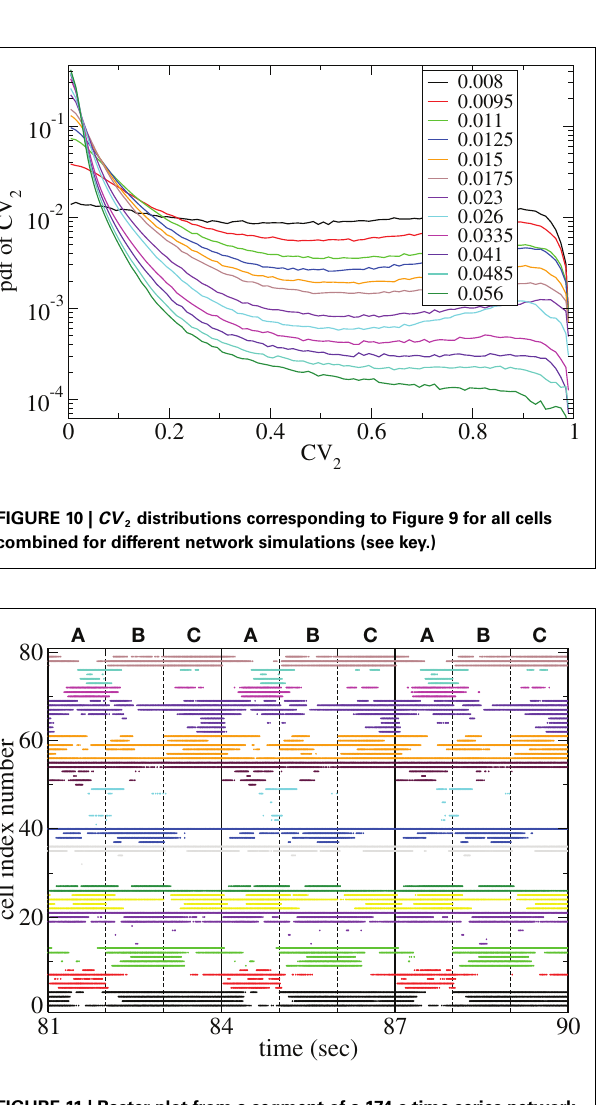
FIGURE 11 | Raster plot from a segment of a 174-s time series network simulation with 100 cells under input switching protocol 1s × 3 stimuli, (see text) cells colored according to assigned cluster. Input strength r C = 0.018 spikes/ms, connectivity ρ = 0.1, tail parameter α = 1.5, synaptic strength b C =